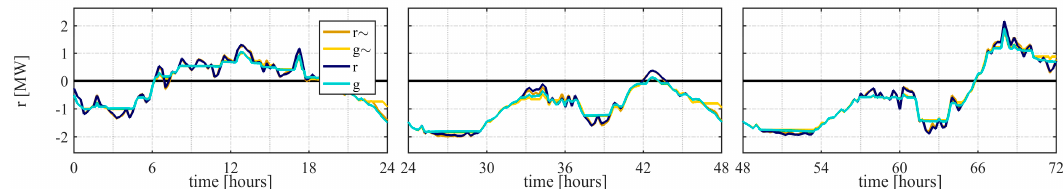
Figure 6. Residual and grid power profiles achieved by OPEM over three days: r ̃ and g ̃ (dark orange and orange, forecast at the start of each day), r (dark blue) and g (cyan).